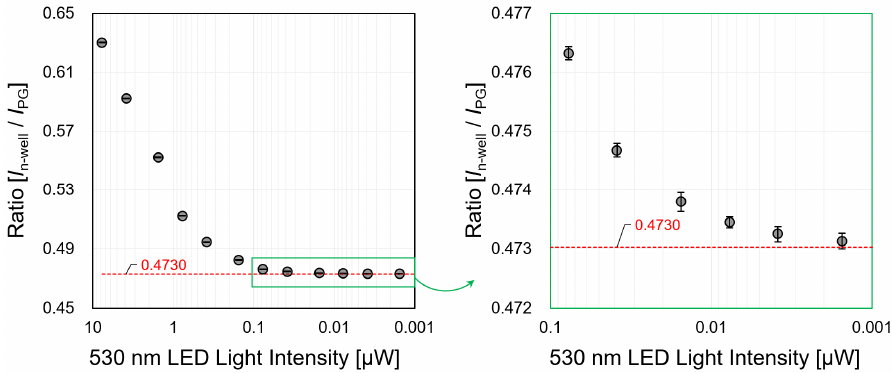
Figure 9. Change in current ratio when the LED light source is irradiated with wavelengths of 490 nm (7.714 μ W) and 530 nm (0.0008–7.7090 μ W), simultaneously.